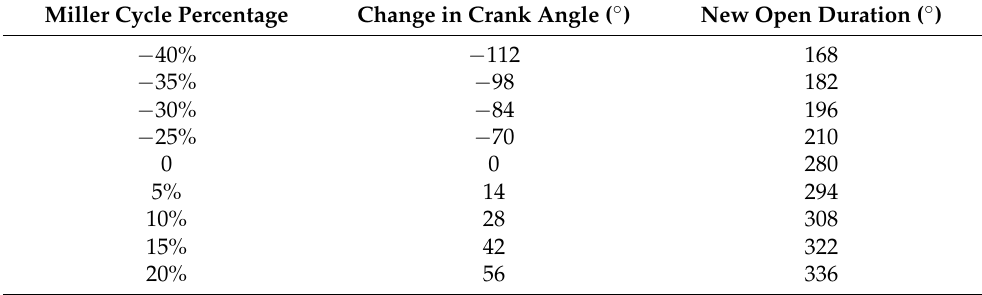
Table 4. Miller cycle setup.